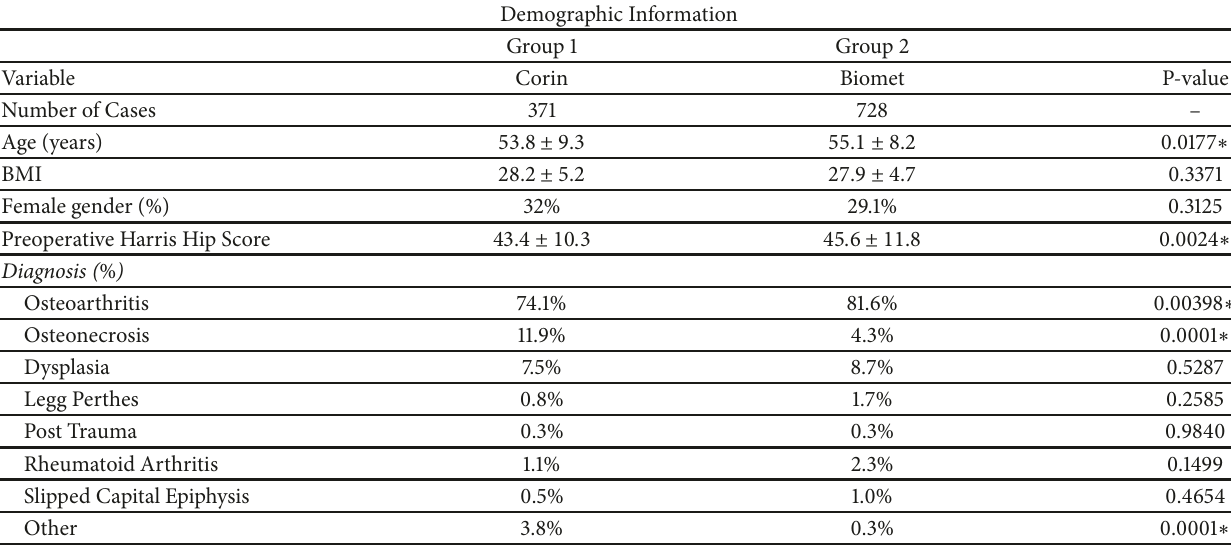
Table 1: Demographic